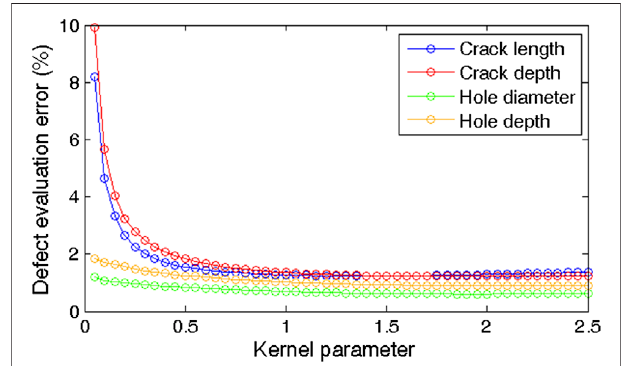
FIGURE 16 | Defect evaluation results of different kernel parameters.